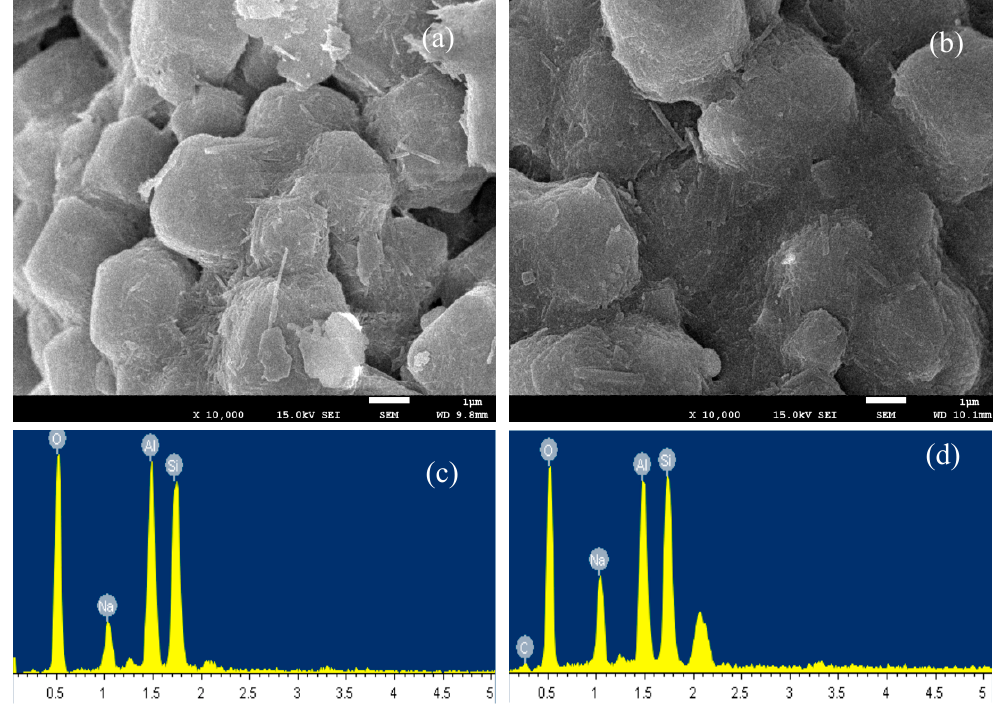
Figure 3. SEM images of MS ( a ) and CMS ( b ) and EDS images of MS ( c ) and CMS ( d ).